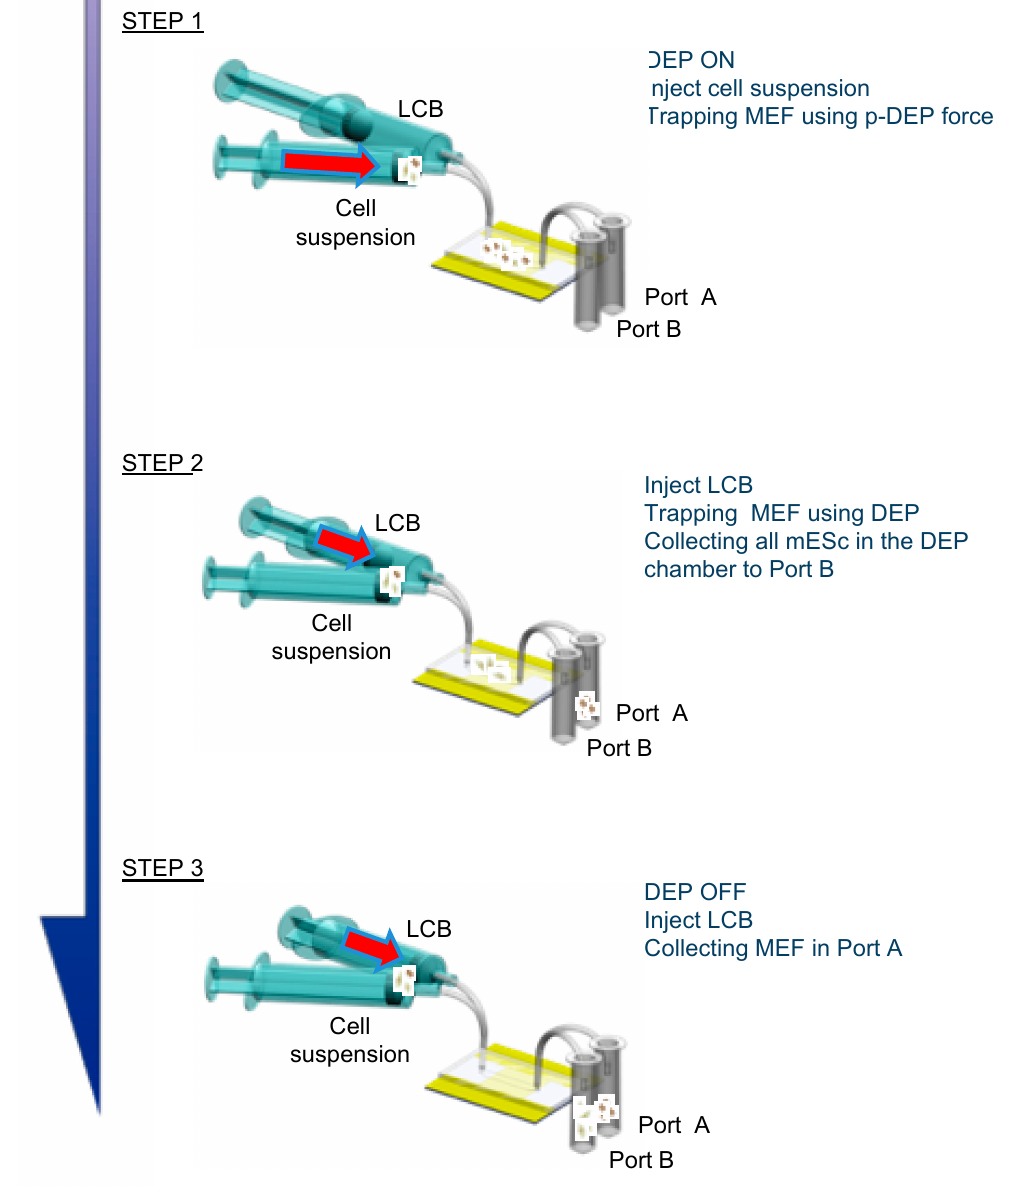
Figure 3. Sorting procedure using positive dielectrophoresis and fluid-flow control.